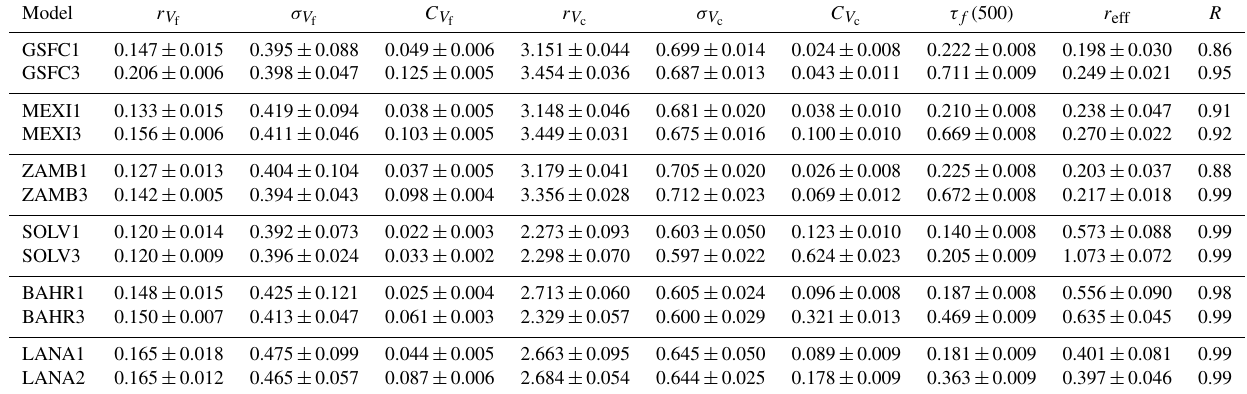
Figure 5. The effect of τ a errors on size distributions retrieved with the GRASP-AOD code for GSFC (a, b) and SOLV (c, d) . The subfigures on the left correspond to the cases with τ a ( 440 ) = 0 . 3, and on the right with τ a ( 440 ) = 0 . 9. Black solid lines are used to illustrate the reference values, while black dashed lines represent the retrievals without errors (self-consistency study). Red and blue lines are used to indicate the cases for which all the wavelengths present the errors of + (cid:15) i and − (cid:15) i respectively. Grey shaded area illustrates all the retrievals for the multiple combinations of random errors. Table 7. Results obtained from the simulation of errors in τ a on GRASP-AOD code. The parameters representing the bimodal log-normal size distribution (volume median radius ( r V , r V [µm]), geometric standard deviation ( σ V and σ V ) and volume concentration ( C V , C V c c c f f f [µm 3 µm − 2 ])) are shown in the first six columns (reference values in Table 1). The following columns contain two secondary products derived from GRASP-AOD inversion: fine-mode aerosol optical depth at 500nm ( τ f ( 500 ) ) and the effective radius ( r eff [µm]) (reference values in Table 3). The last column R indicates the fraction of the inversions that pass the filters out of the original 1000 simulations.